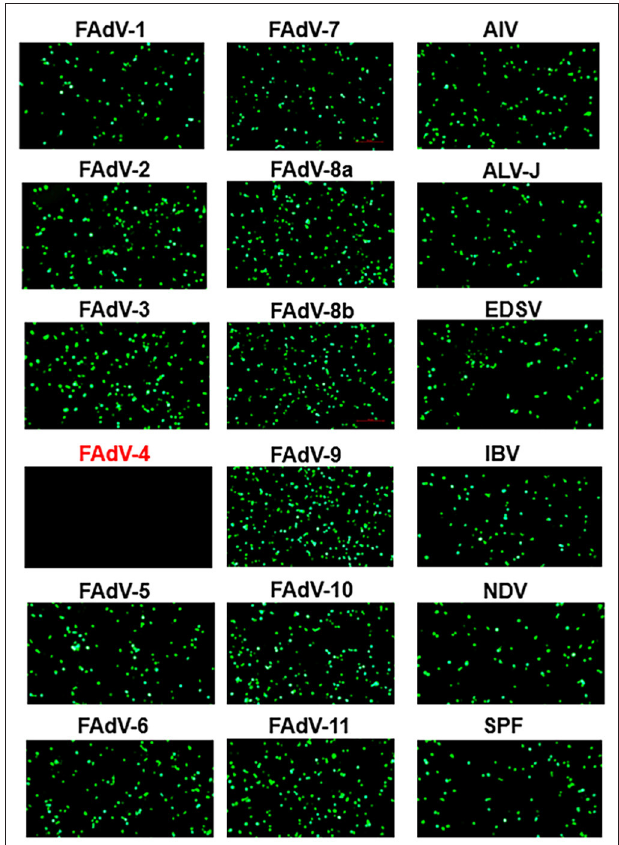
FIGURE 2 | Specificity assay of the novel VNT. Positive sera against FAdV-1-7, − 8a, − 8b, − 9-11, influenza A (H9N2) virus (AIV), avian leukosis virus subgroup J (ALV-J), Newcastle disease virus (NDV), infectious bronchitis virus (IBV), and egg-drop syndrome virus (EDSV), and sera from the SPF chicken were used to evaluate the specificity of the novel VNT. The EGFP could be found in the LMH cells with the incubation of FA4-EGFP with positive sera against other viruses at 24 hpi, but not be found in that with FAdV-4 chicken positive sera.